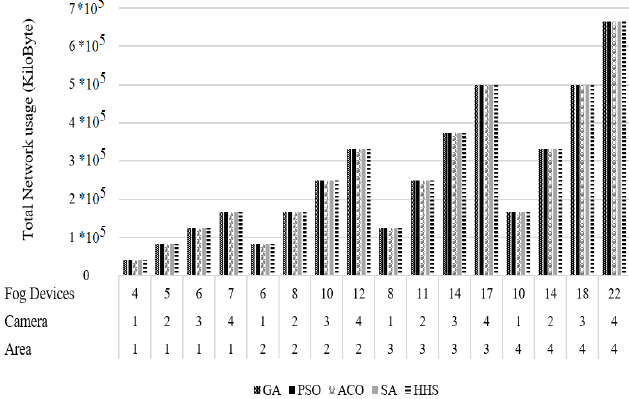
Figure 6. Total network usage of GA, PSO, ACO, SA, and